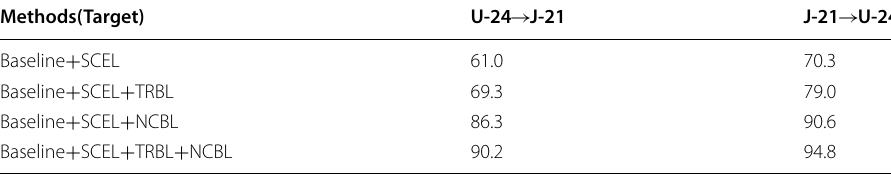
“Baseline xxx” means that the “xxx” loss function is used upon the baseline model. SCEL stands for supervised cross- + entropy loss, TRBL stands for tracking-regularization-based loss, NCBL means neighbor-consistency-based